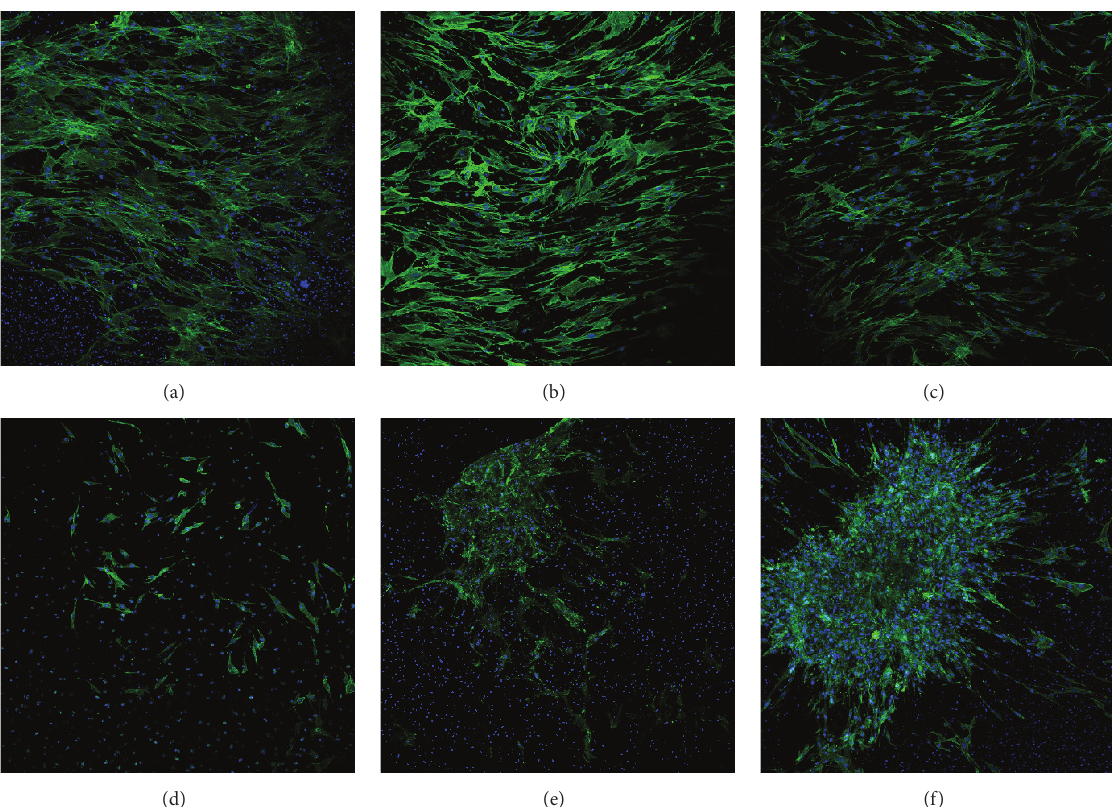
Figure 5: MSC dispersion on cartilage with increasing concentration of HA. MSCs were cultured until the second passage before use in this experiment. Cartilage discs were used to plug the bottom of a 96-well place in the correct orientation. Media formulations were then added to each well. The media formulations used were (a) 0.5 mg/mL HA media, (b) 1mg/mL HA media, (c) 2mg/mL HA media, (d) 3mg/mL HA media, (e) 4mg/mL HA media, and (f) 5mg/mL HA media. MSCs were then stripped using TrypLE, counted using standard enumeration technique, and then seeded onto the cartilage discs at a density of 5 × 10 3 cells/disc. The 96-well plate was then incubated for 24 hours at 37 ∘ C and 5% CO 2 . After 24 hours the cartilage discs were washed in PBS and then fixed in 4% paraformaldehyde. Cartilage discs were washed in PBSandthenstainedinusingHoechst33342(blue)andagainwashedfivetimesinPBS.Cartilagediscswerethenpermeabilisedin0.1%Triton X-100, washed in PBS, and blocked in 1% Bovine serum albumin in PBS before being stained with F-actin-specific Alexa Fluor 488-phalloidin (green). All images were taken using the OLYMPUS FLUOVIEW FV1000 IX81 inverted confocal microscope at 10x